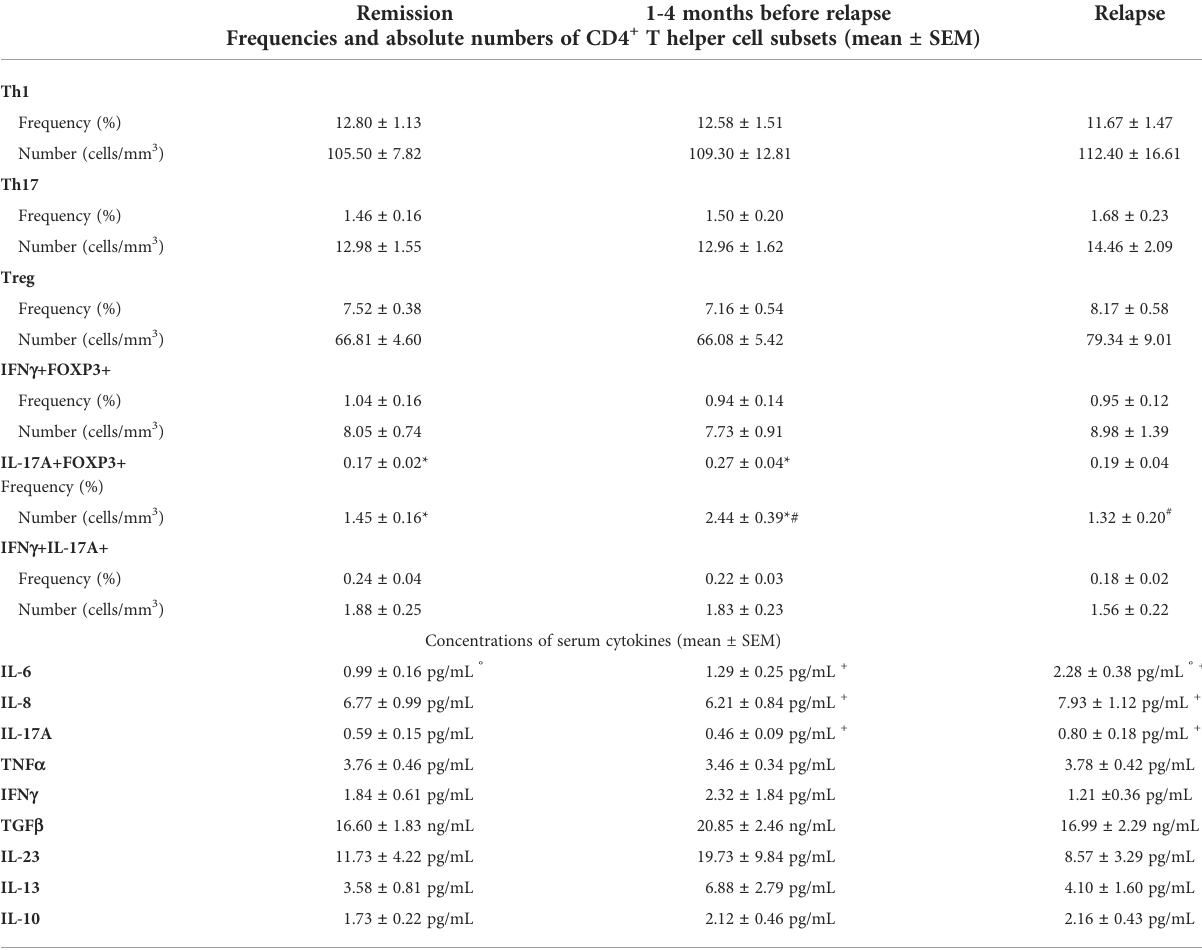
TABLE 2 Frequencies and absolute numbers of CD4 + T helper cell subsets and concentration of serum cytokines (mean ±